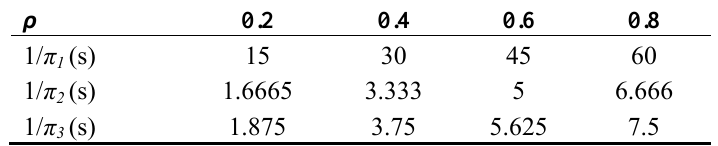
Table 2. Average service lifetime values (seconds) per class utilized in the